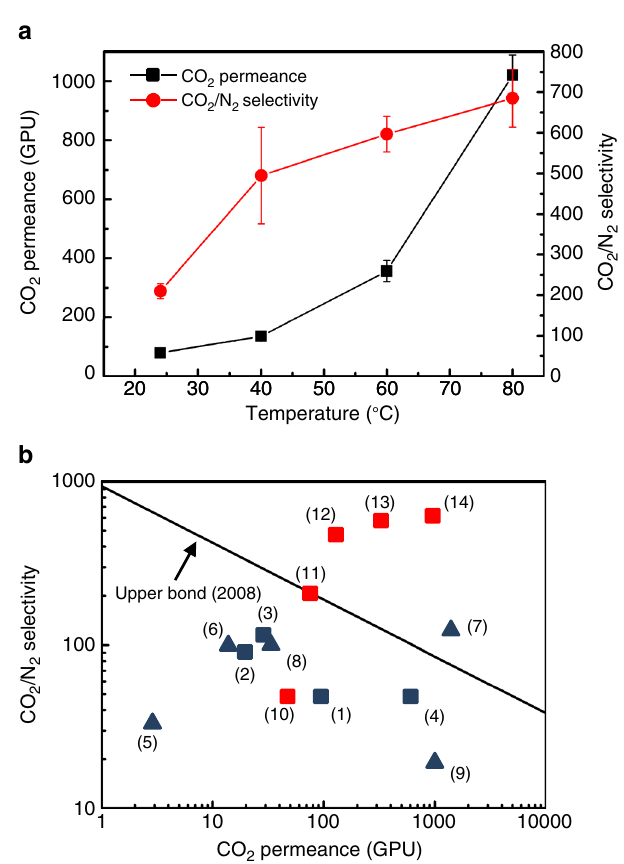
Fig. 4 CO 2 /N 2 mixture separation performance of GOP membranes and comparison with membranes reported in the literature. a In fl uence of temperature on GOP membrane performance for mixed gas (CO 2 : N 2 = 15%: 85%, vol%) separation under wet condition. It is noted that some error bars of CO 2 permeance were smaller than the cubic symbol, and thus they are not shown in the fi gure. b Performance comparison of GOP membranes with polymeric membranes (black line) reported in 2008 upper bound 11 (modi fi ed upper bond (in GPU), thickness of polymer membranes is assumed to be 100 nm) and some representative recent membranes 6 – 8, 19, 21 – 23, 41, 42 . Squares denote the GO-based membranes; triangles denote the polymer-based membranes. (1) GO 19 . (2) GO-Pebax 22 . (3) GO-PEI 23 . (4) GO-Borate 21 . (5) Pebax-PEG-POSS 6 . (6)